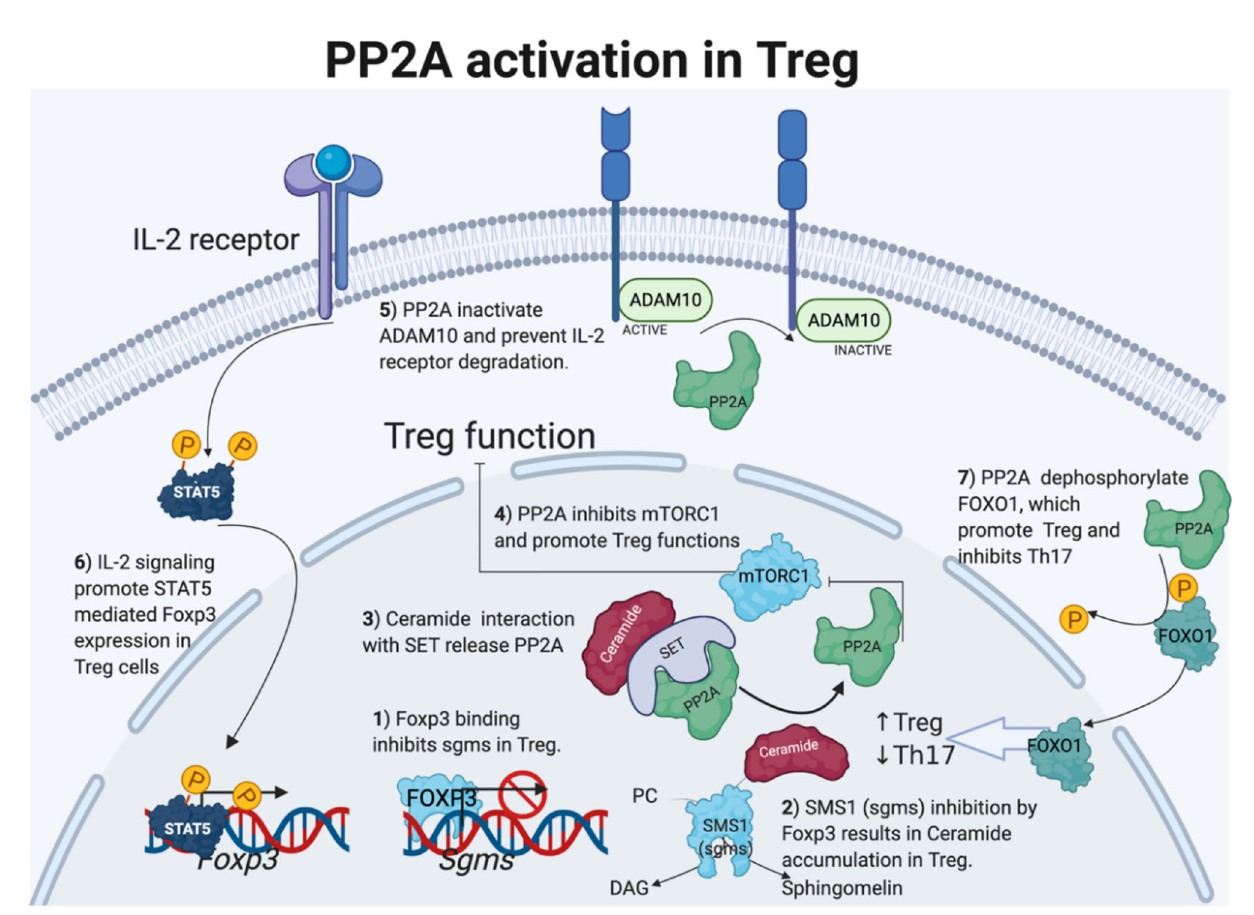
FIGURE 2 | PP2A activation in Treg cells. Foxp3 direct sgms1 gene promoter binding and inhibits sgms1 expression in Treg. SMS1 (encoded by sgms1) reduction results in ceramide accumulation. Ceramide accumulates only in Treg cells, and the interaction with TCR-activated PP2A endogenous inhibitor SET activates PP2A. On the other hand, PP2A activity in Treg cells is important to inhibit mTORC1 and ADAM10 to the IL-2 receptor. Enhanced IL-2 signaling promotes STAT5 and Foxp3 expression in Treg cells. Lastly, PP2A dephosphorylation activates Foxo1, which positively regulates Treg-cell differentiation but inhibits Th17 cells. Figure 2 is modi fi ed from the thesis (24) and prepared using